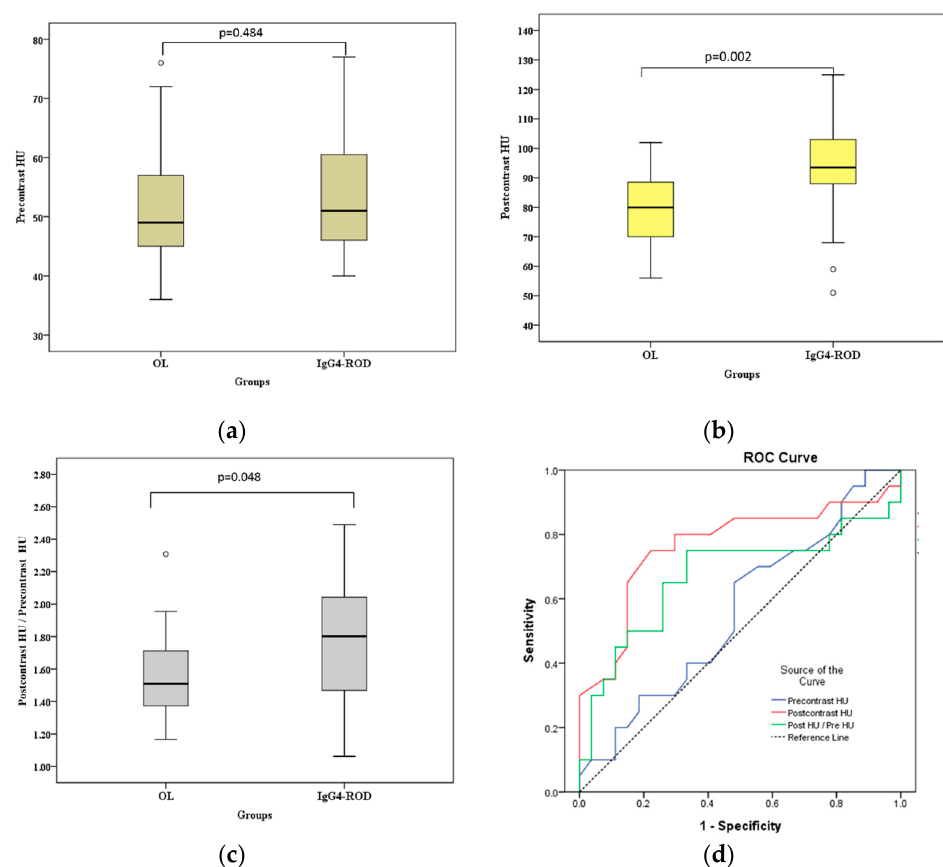
Figure 3. Box-and-whisker plots and receiver operating characteristic (ROC) curve analysis of precontrast computed tomography (CT) Hounsfield unit scale (CTHU), postcontrast CTHU, postcontrast CTHU / precontrastCTHUratiosbetweenorbitallymphoma(OL)andimmunoglobulinG4-relatedorbital disease (IgG4-ROD). Bars = medians. ( a ) Precontrast CTHU (precontrast HU) shows a nonsignificant di ff erence between the two groups ( p = 0.484, Mann–Whitney U test); ( b ) Postcontrast CTHU (postcontrast HU) shows a significant di ff erence between the two groups ( p = 0.002, Mann–Whitney U test); ( c ) Postcontrast CTHU / precontrast CTHU ratios (postcontrast HU / precontrast HU) show a significant di ff erence between the two groups ( p = 0.048, Mann–Whitney U test); ( d ) Areas under the ROC curve (AUC) of precontrast CTHU (precontrast HU), postcontast CTHU (postcontrast HU) and postcontrast CTHU / precontrast CTHU ratios (postcontrast HU / precontrast HU) are 0.56 (95% CI: 0.393–0.727, p = 0.484), 0.766 (95% CI: 0.615–0.917, p = 0.002) and 0.670 (95% CI: 0.498–0.842, p = 0.048), respectively. —anoutlier.